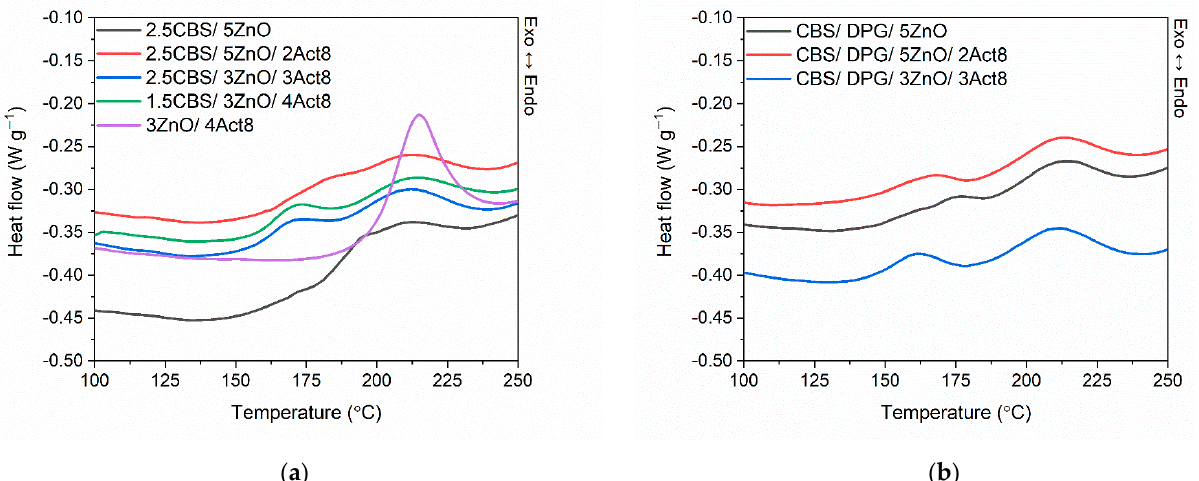
Figure 2. Differential scanning calorimetry (DSC) curves of SBR compounds containing: ( a ) CBS; ( b ) CBS and DPG. Table 3. Crosslinking temperature and enthalpy ( Δ H cross ) of SBR compounds determined by differ- ential scanning calorimetry (DSC).